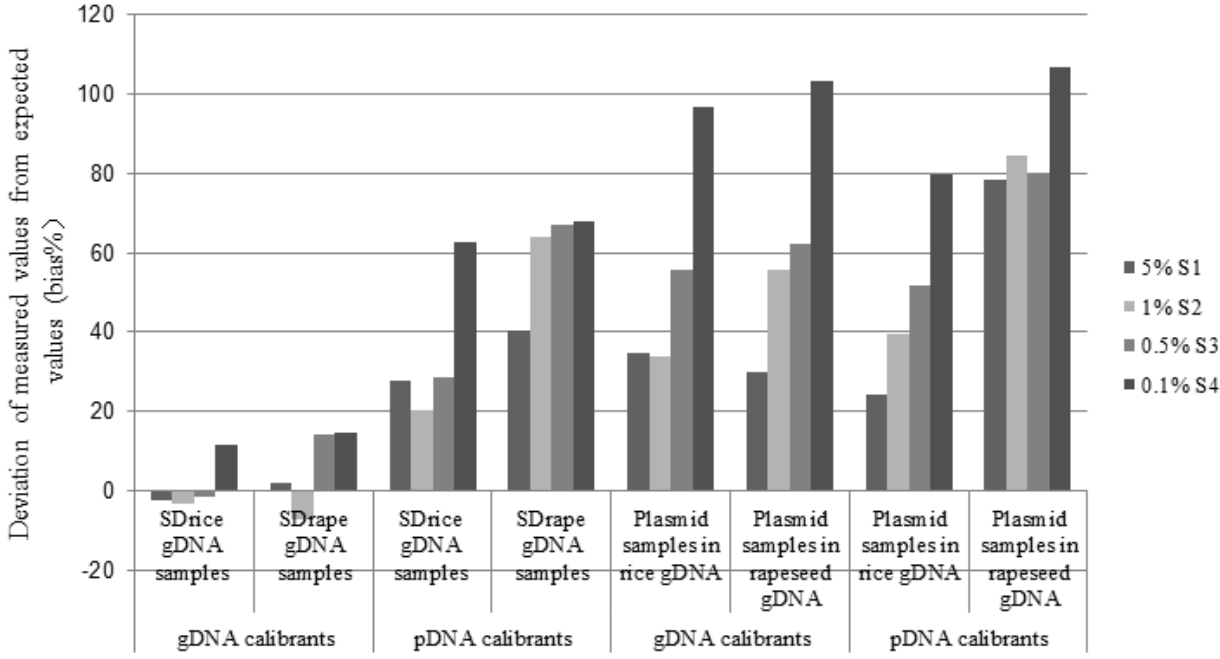
Figure 1. Relative bias of the quantitative results of the test samples from the expected value by the quantitative polymerase chain reaction assays targeting T-NOS.